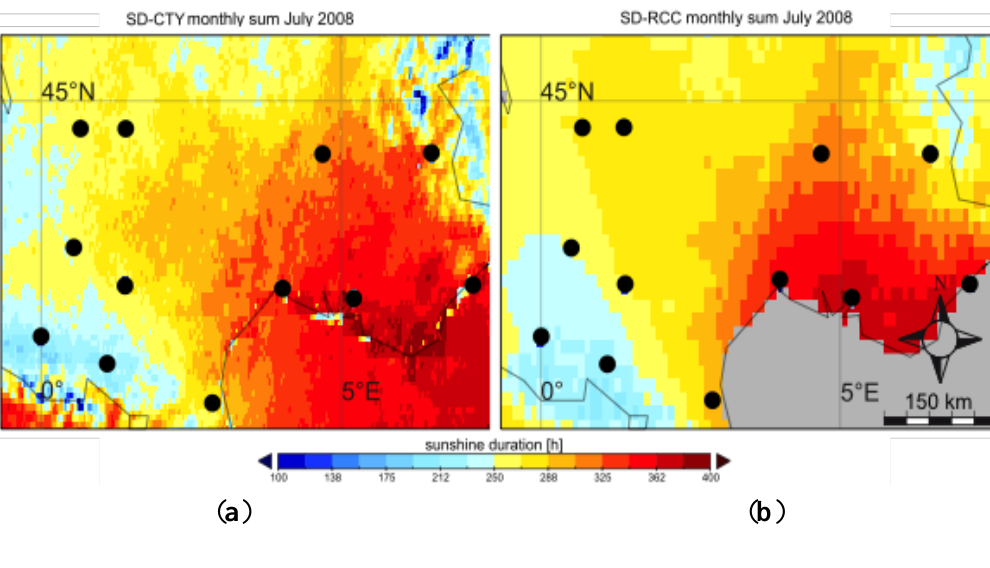
Figure 7. SD-CTY ( a ) and for SD-RCC ( b ) for July 2008. The figures show a sector of about 3° longitude × 8° latitude centered over the south of